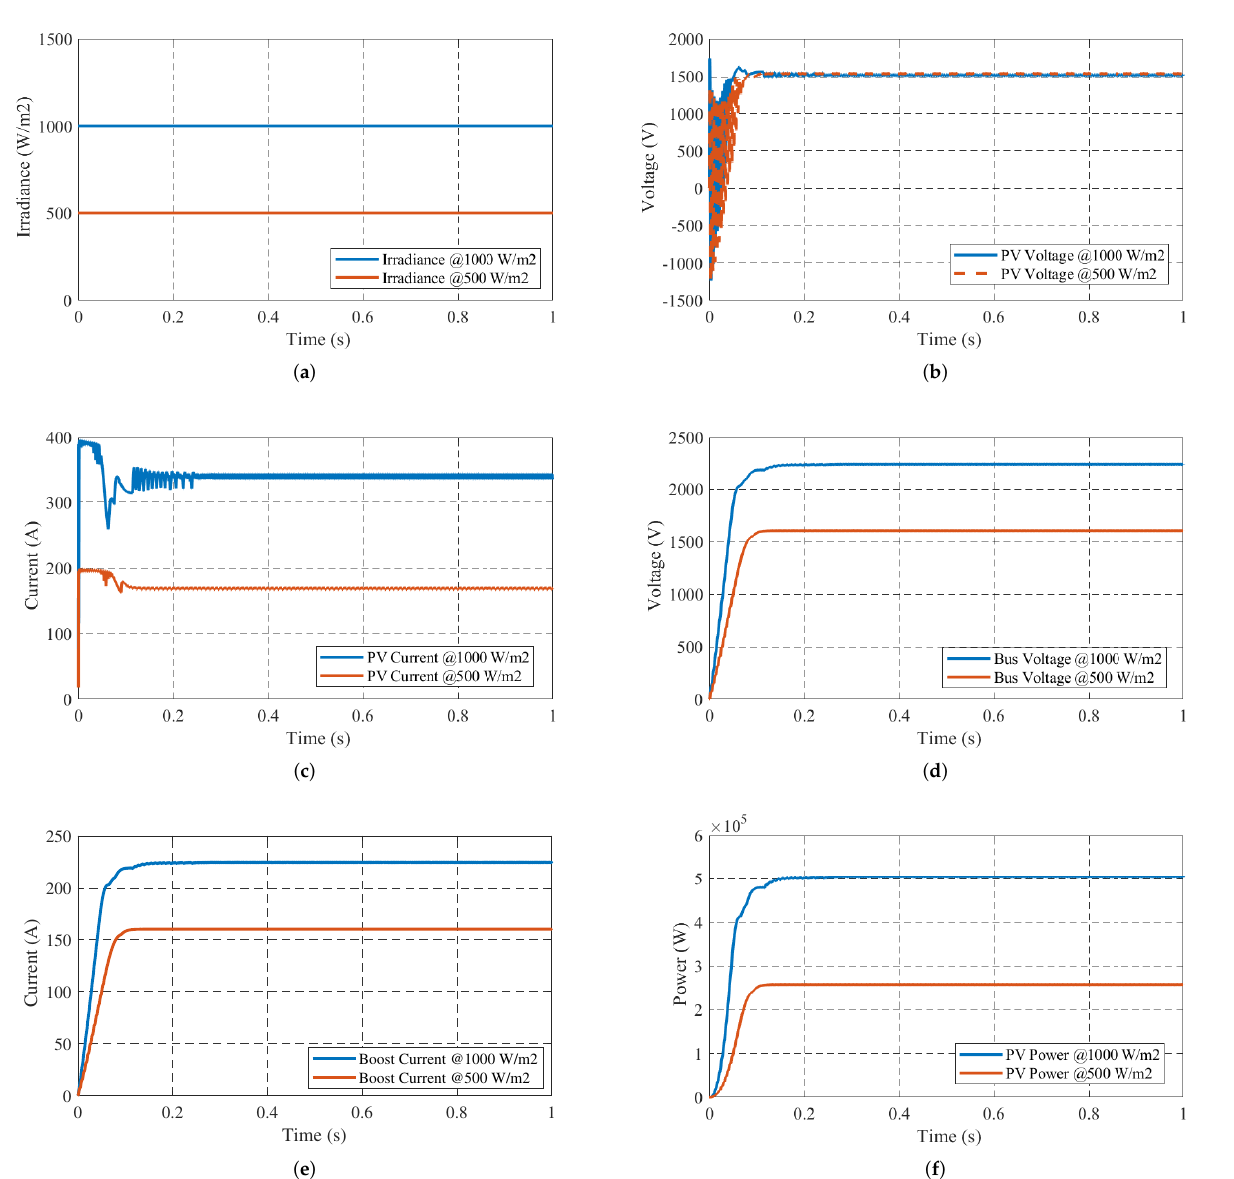
Figure 8. ( a ) Irradiance value, ( b ) PV voltage, ( c ) PV current, ( d ) bus voltage, ( e ) boost current, and ( f ) power extracted from the PV